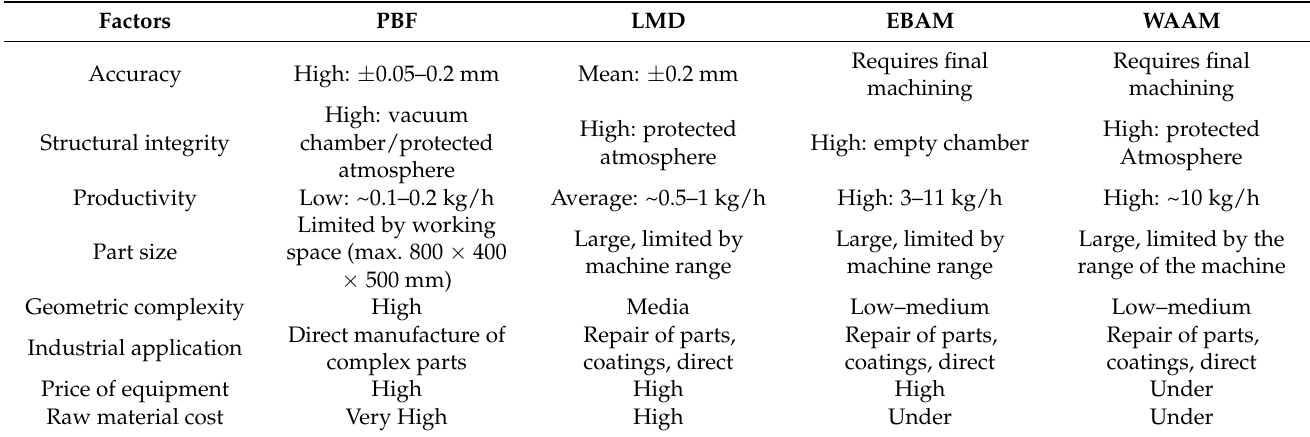
Table 1. Comparison of main metal additive-manufacturing processes